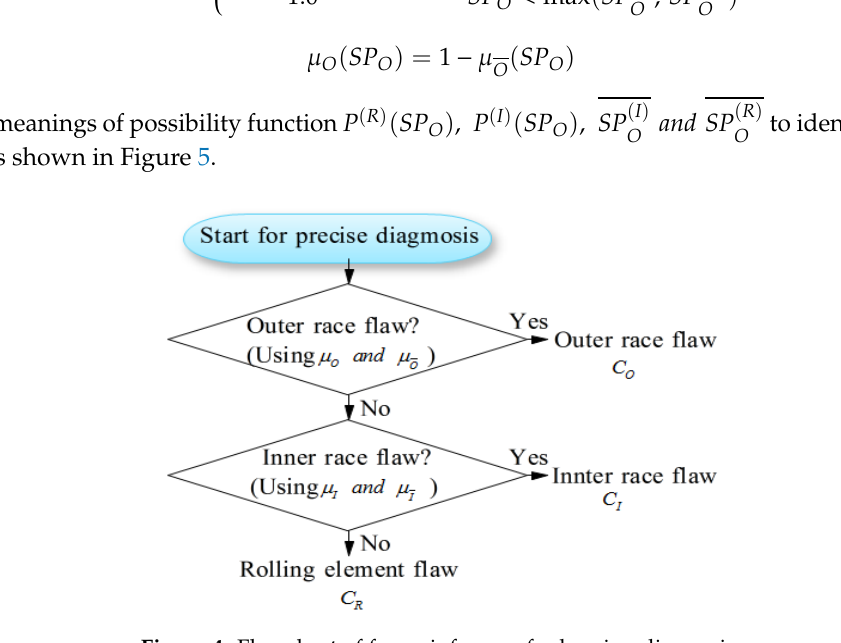
Figure 4. Flowchart of fuzzy inference for bearing diagnosis.